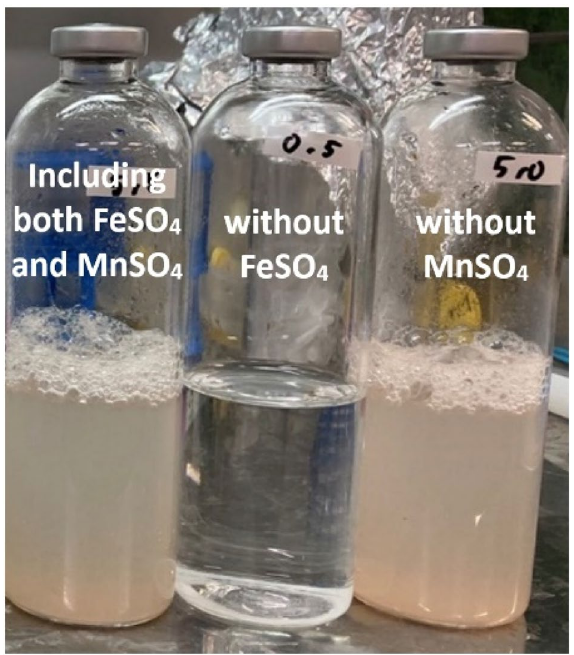
Figure 7. Photo image of the culture solution of P . aeruginosa cultured in the Cooper’s medium for 2 days. P . aeruginosa was cultured in the Cooper’s medium containing both ferrous sulfate and manganese sulfate (left), without ferrous sulfate (center) and without manganese sulfate (right). Both turbidity in the culture solution and foam, which were derived by the growth and metabolism of P . aeruginosa were observed in only